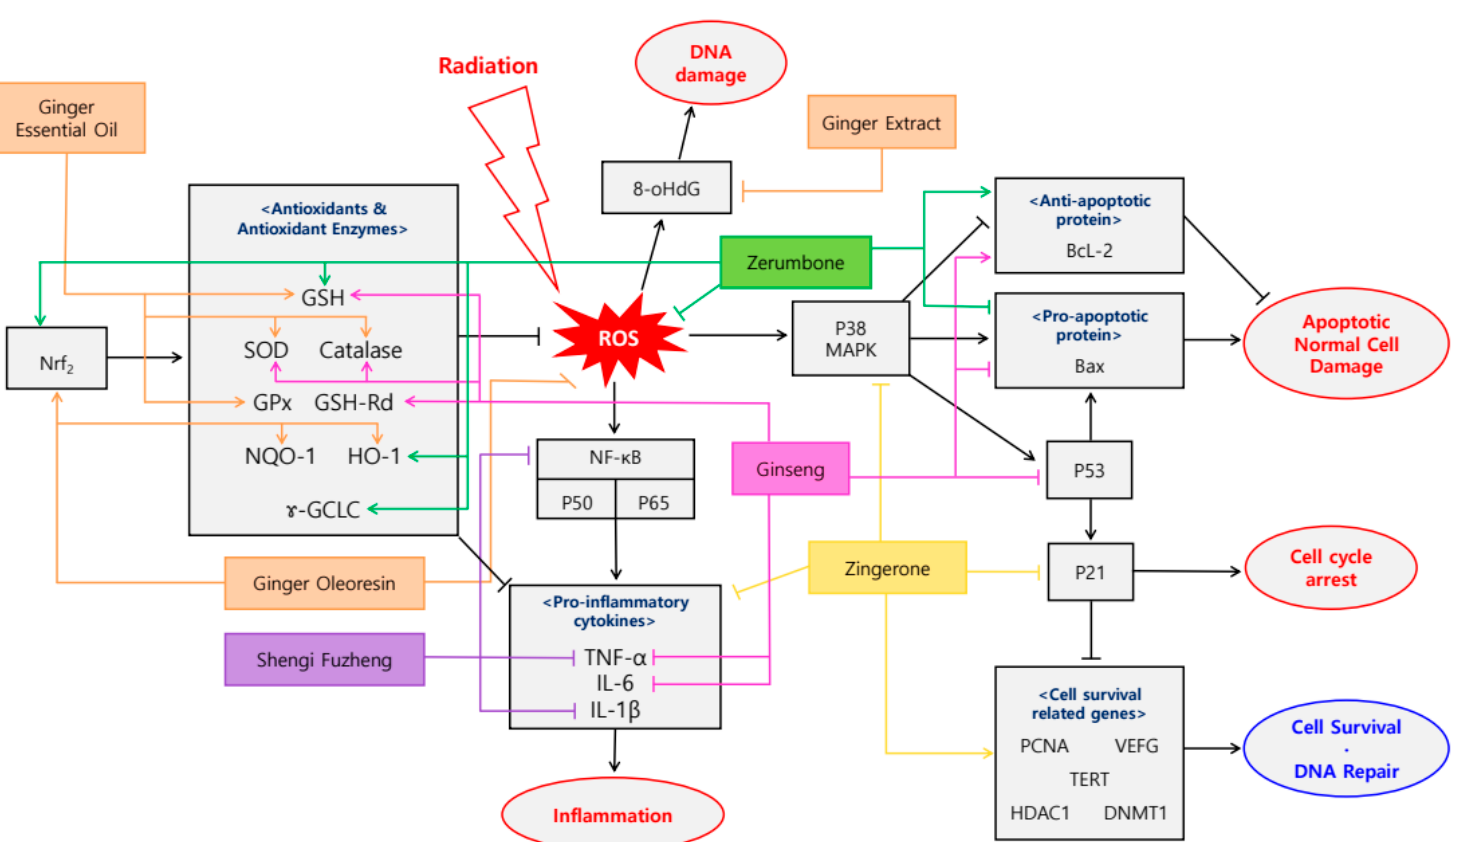
Figure 2. Schematic diagram of anti-inflammatory & antioxidant mechanisms of plant-derived drugs in sequela of radiotherapy.